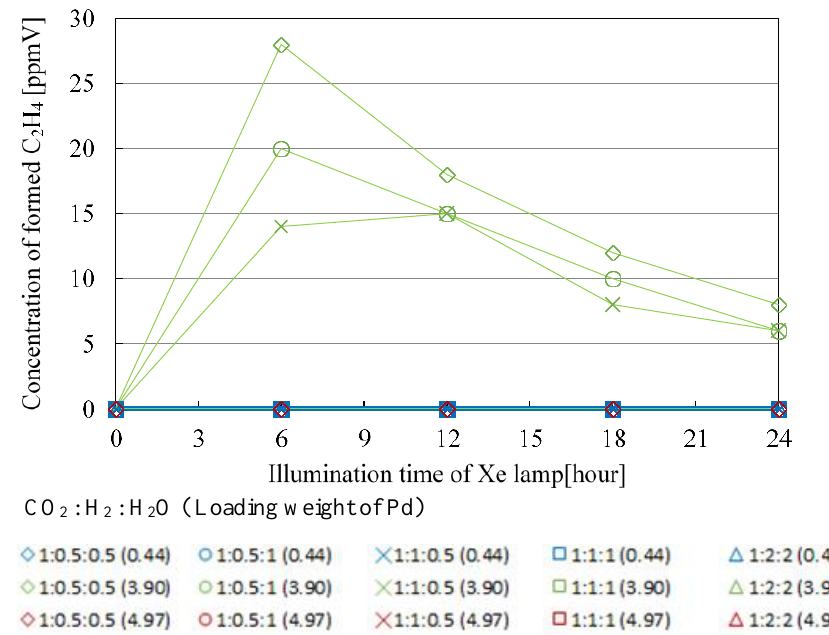
Figure 9. Change in concentration of formed C 2 H 4 with the illumination time among different molar ratios of CO 2 /H 2 /H 2 O and Pd loading weight with UV light illumination.